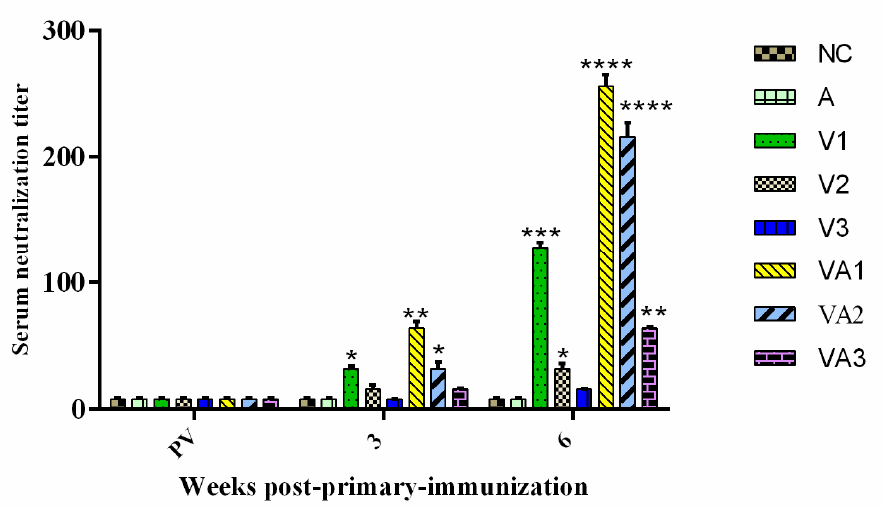
Figure 2. Detection of TiLV-specific serum neutralizing antibodies induced in the vaccinated tilapia: five serum samples from each group collected pre-vaccination (PV) and at three and six weeks post primary immunization (WPPI) were tested by the serum neutralization test to determine the antibody titers against the virulent isolates TiLV 2017A. A comparison between the vaccinated groups V1, V2, V3, VA1, VA2, and VA3 with the NC or A groups is shown. Differences in the antibody levels between vaccinated and control fish were analyzed by the Student’s t -test. The different numbers of asterisks indicate significant differences in antibody levels at * p < 0.05, ** p < 0.05, *** p < 0.01 and **** p <